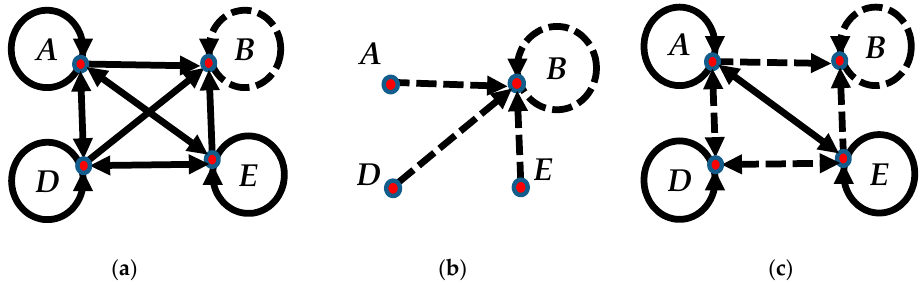
Figure 2. ( a ) An example of maximal graph of a good puzzle with 13 edges that contains a maximum number of solid edges: 12. ( b ) Graph of a good puzzle with a minimum number of edges, which is 4, and a minimum number of solid edges, which is 0. ( c ) An example of a graph representation of a good puzzle with a maximum number of broken edges, which is 7. Table 4. The number of SS- and SSS-puzzles with one, two, three, four, five, or more solutions for puzzles with two, three or four persons.